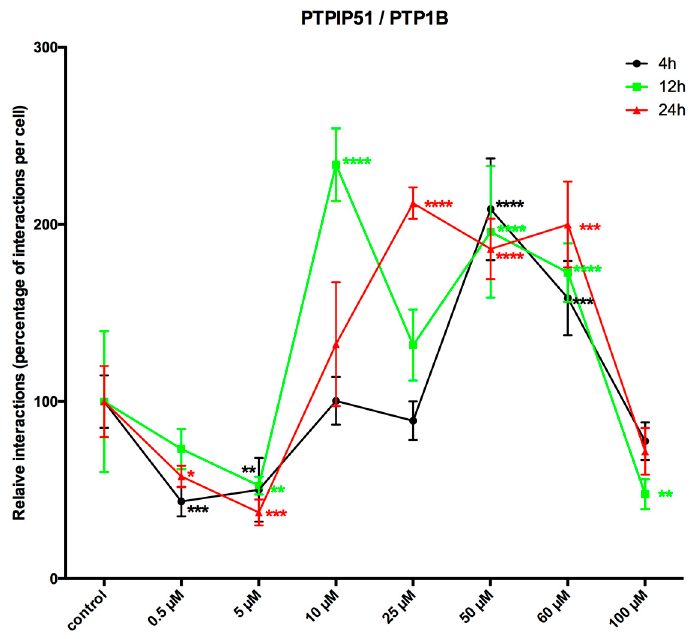
Figure 6. LDC-3 effects on the time dependent interaction profile of PTPIP51 and PTP1B. Quantitative analysis of the Duolink proximity ligation assay of PTPIP51 and PTP1B ( n = 4). The interactions were evaluated by Duolink Image Tool software in untreated controls and in cells treated with 0.5 μ M, 5